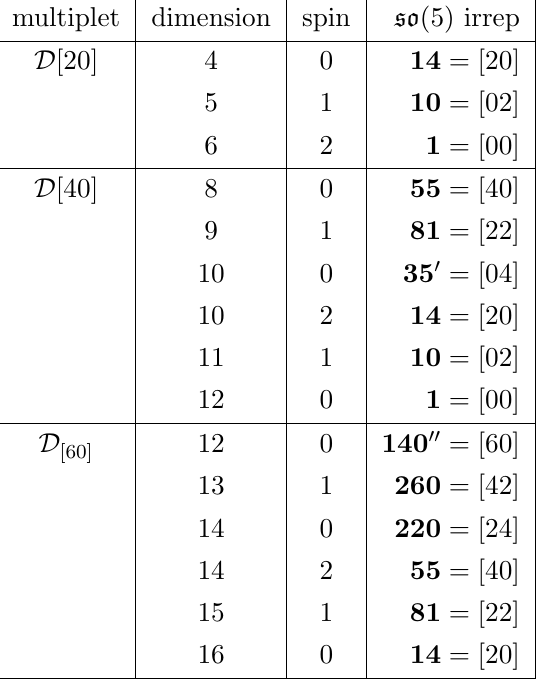
Table 1 . The conformal primaries that appear in each half-BPS supermultiplet in S k (cid:2) S k for k = 2 ;